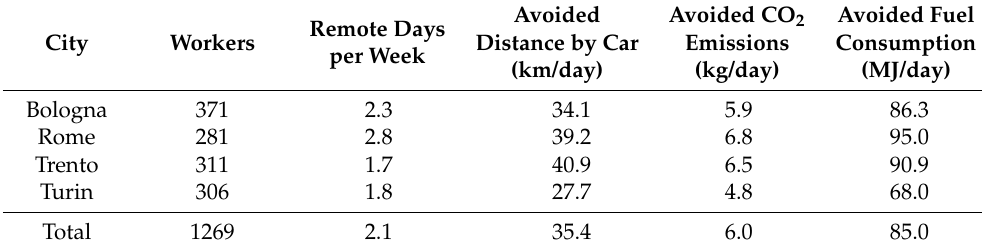
Table 5. Selected average indicators for remote workers travelling exclusively or partially by car for each